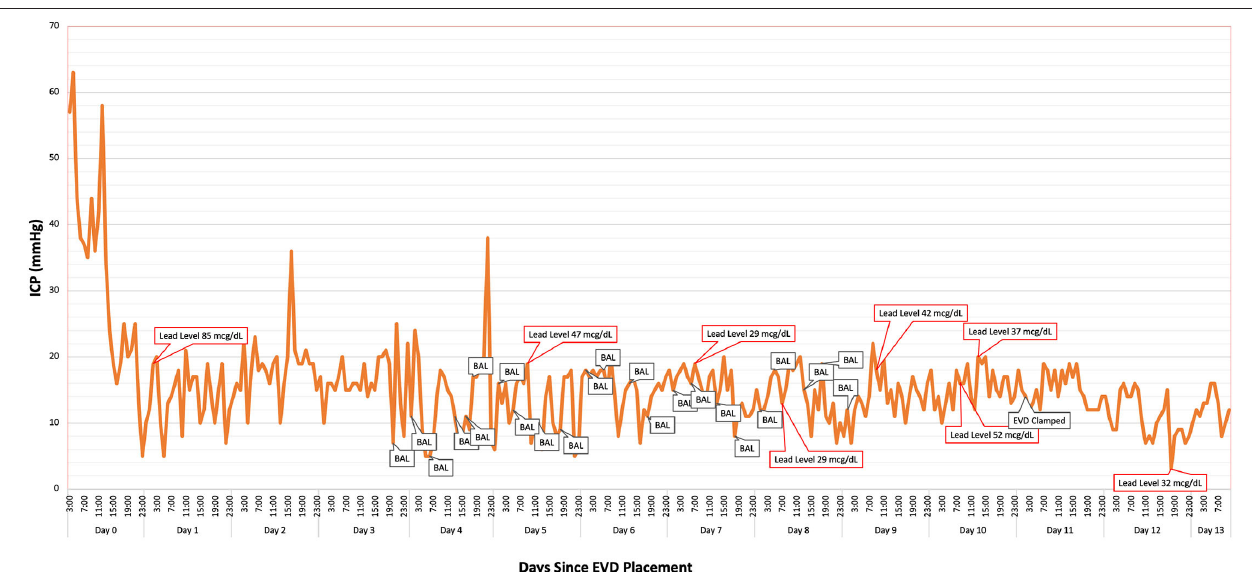
FIGURE 3 | Intracranial pressure (ICP) was monitored continuously via the patient’s ventriculostomy. British anti-Lewsite (BAL: dimercaprol) injection times likely corresponded to intermittent elevations in ICP. Optimal pain sedation with hydromorphone, midazolam, and lidocaine helped mitigate the severity of the spikes. A steady decline in the patient’s lead levels corresponded to improvement in her cerebral edema and ICP. Lead concentration was 14 mcg/dl at 5 days post-EVD removal.